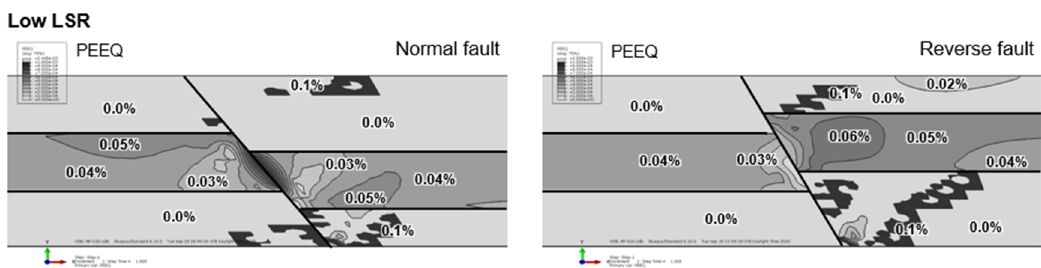
Figure 10. Contours of the equivalent plastic strain for the low LSR scenario in the normal fault ( left ) and reverse fault ( right ) geometries. The range in the legends is 0–0.25%.